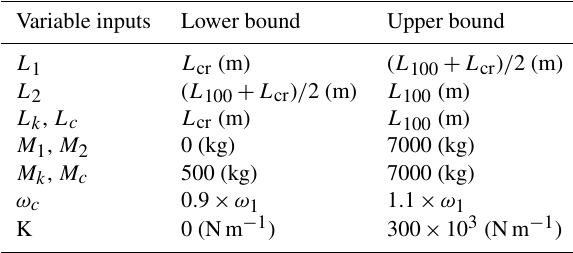
Table 2. Range of variable input parameters.